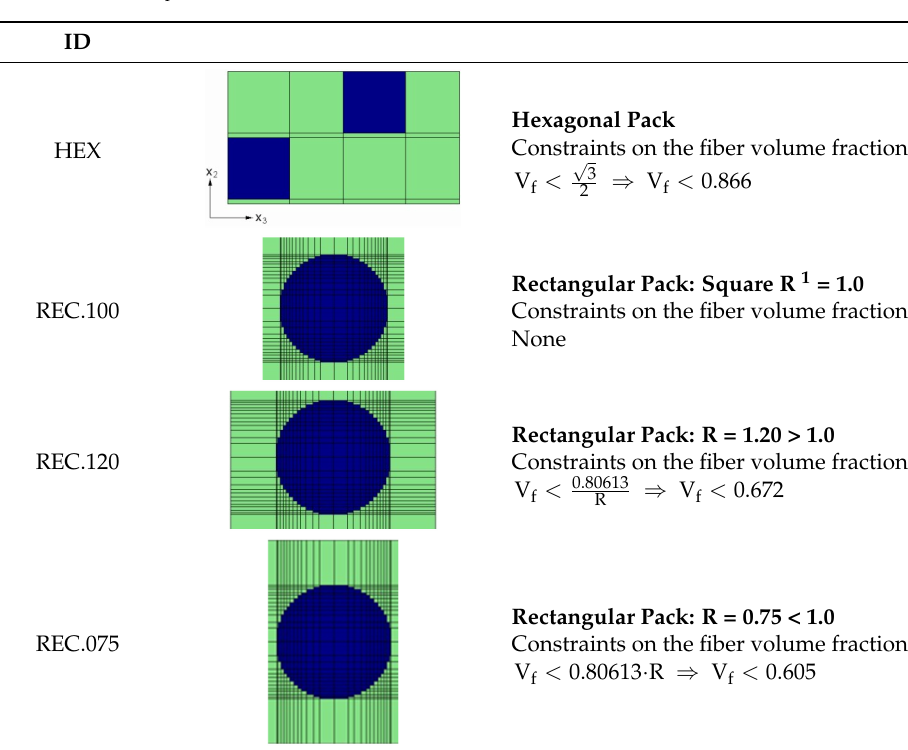
Table 1. Periodic fiber arrangements of doubly periodic RUC architectures applied with constant volume fraction V f = 0.60.